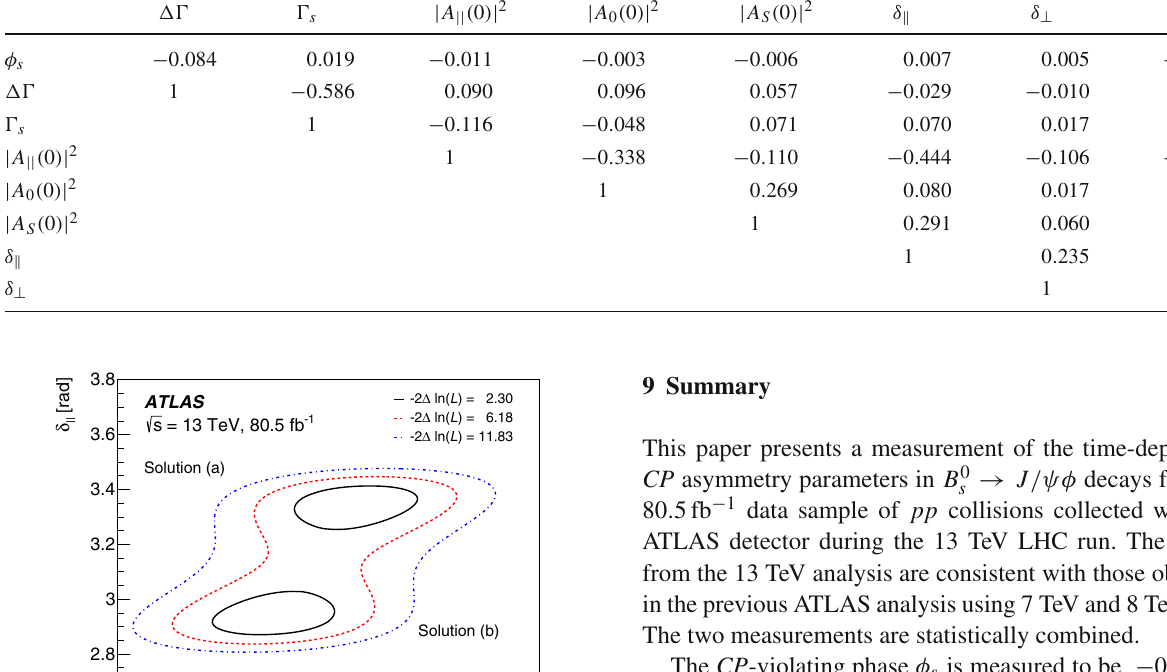
Table 8 Fit correlations between the physical parameters of interest, obtained from the fit for solution (b)